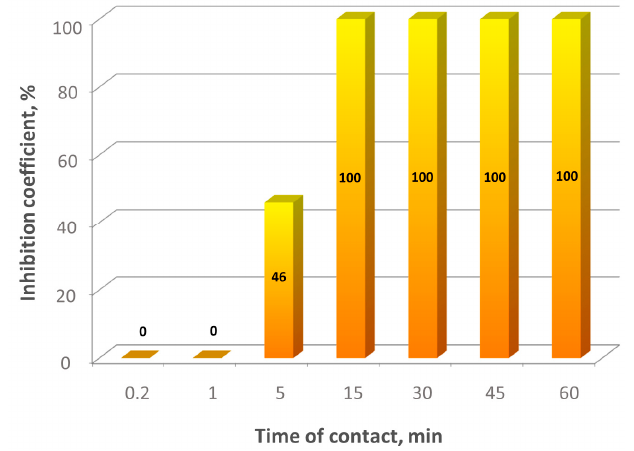
Figure 5. Kinetics of SARS-CoV-2 inactivation by 0.14 mM benzalkonium chloride at different virus-disinfectant contact times.